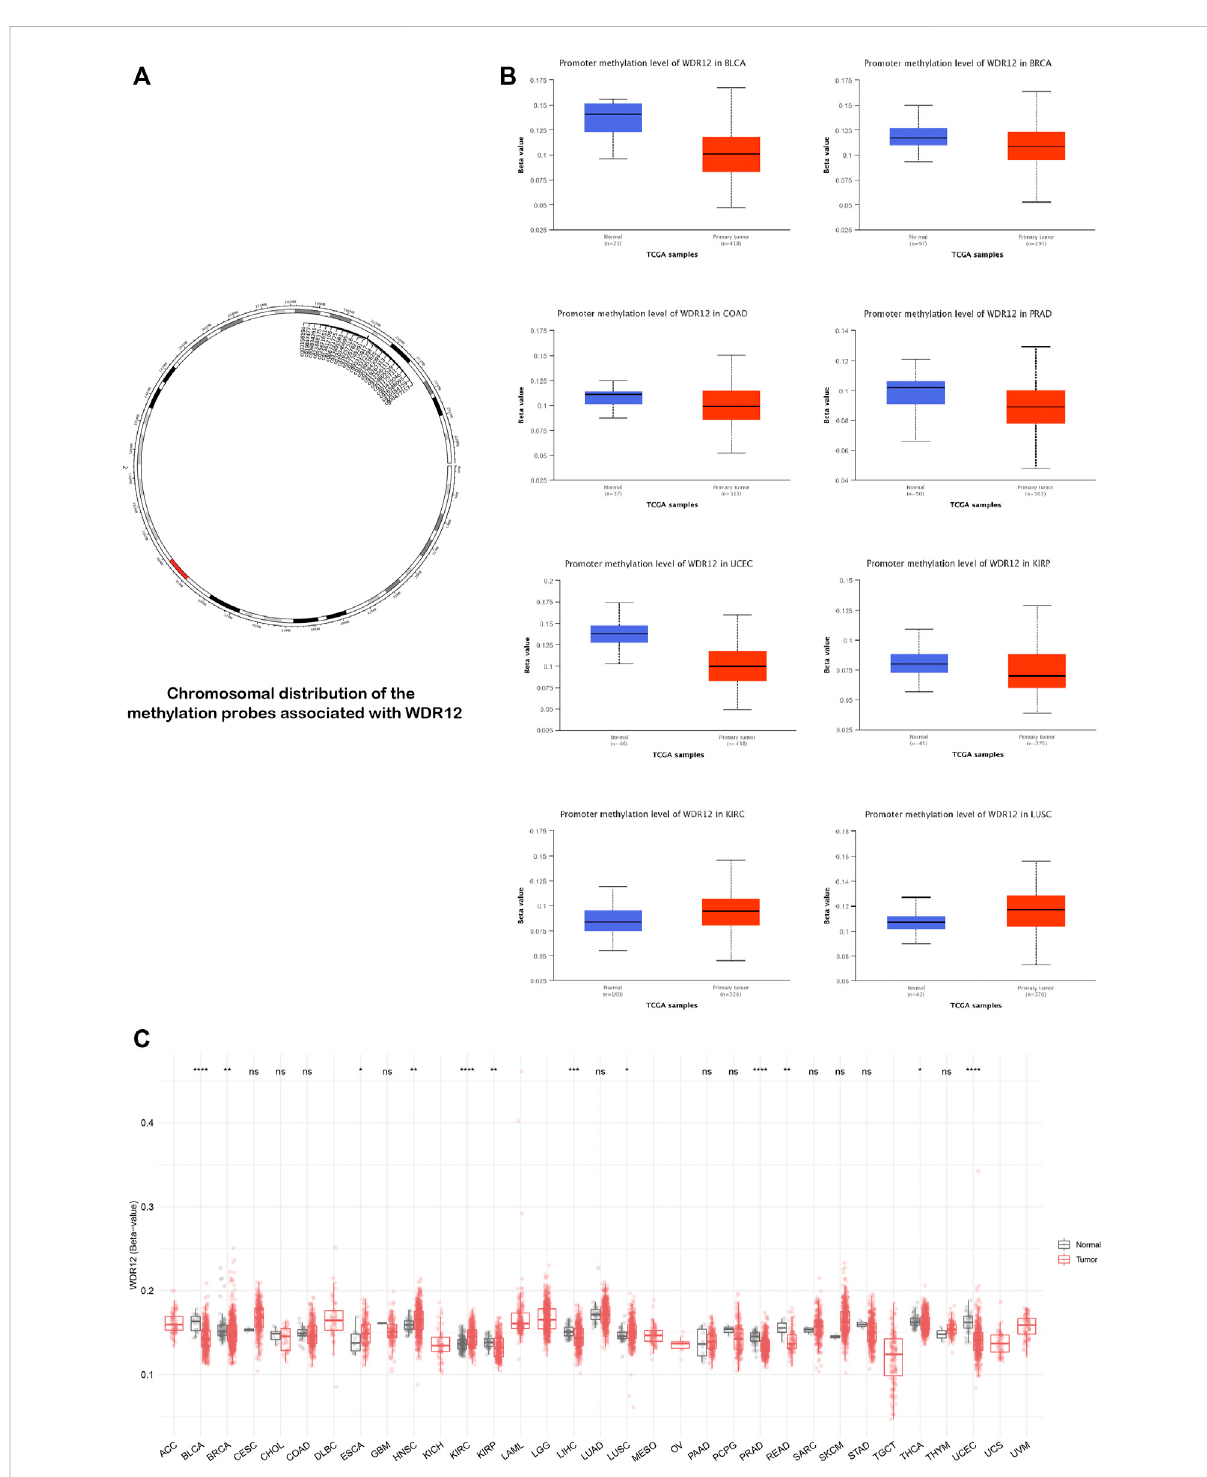
FIGURE 5 Differential methylation analysis of WDR12 in tumor samples versus normal ones. (A) Chromosomal distribution of methylation probes associated with WDR12; (B) tumors experienced higher methylation in the WDR12 promoter region in normal samples versus tumors as assessed by UALCAN analysis; (C) analysis of CpG-aggregated methylation of WDR12 in a list of human